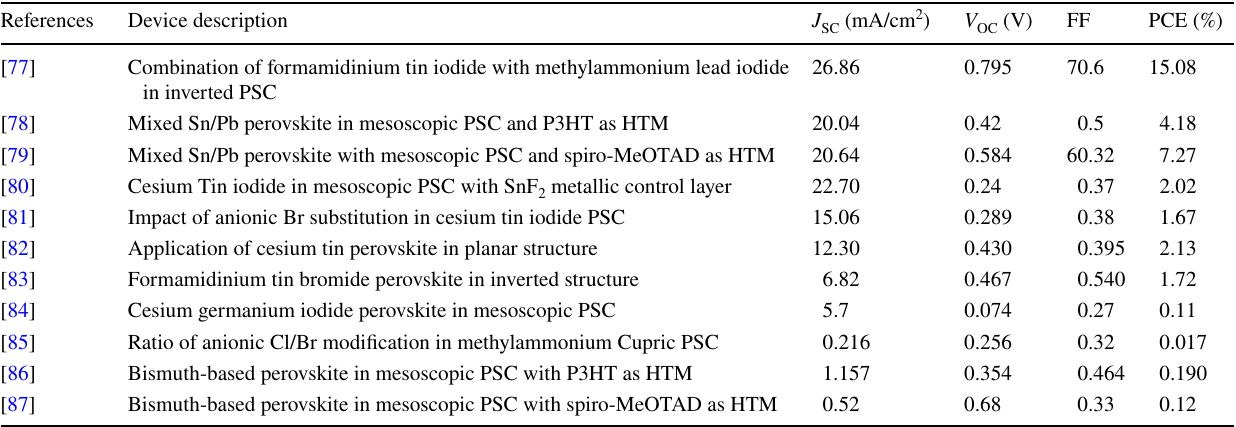
Table 2 Research on lead free perovskite and its